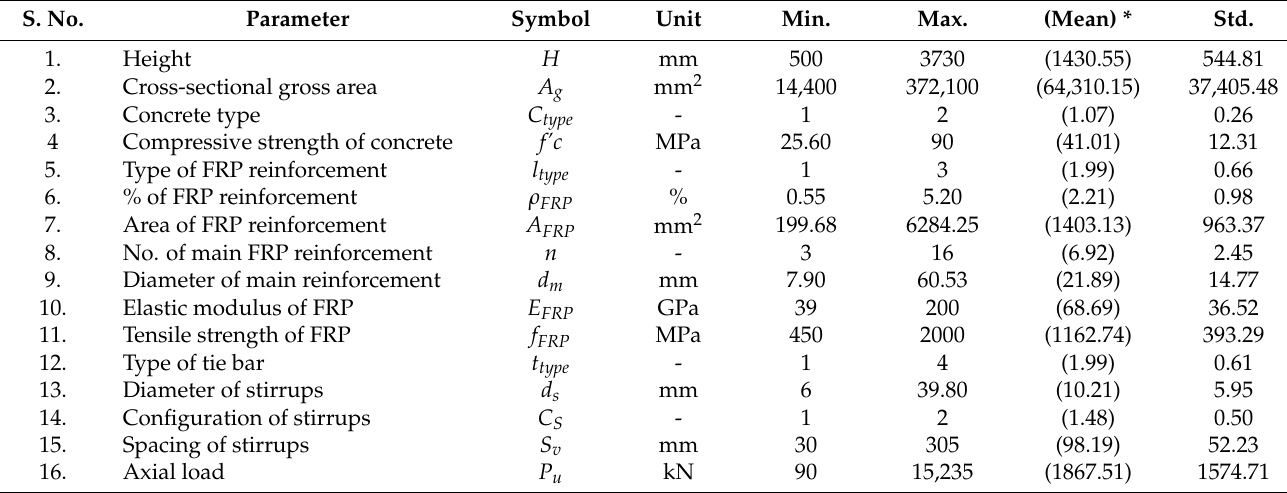
Table 2. Statistical properties of the selected